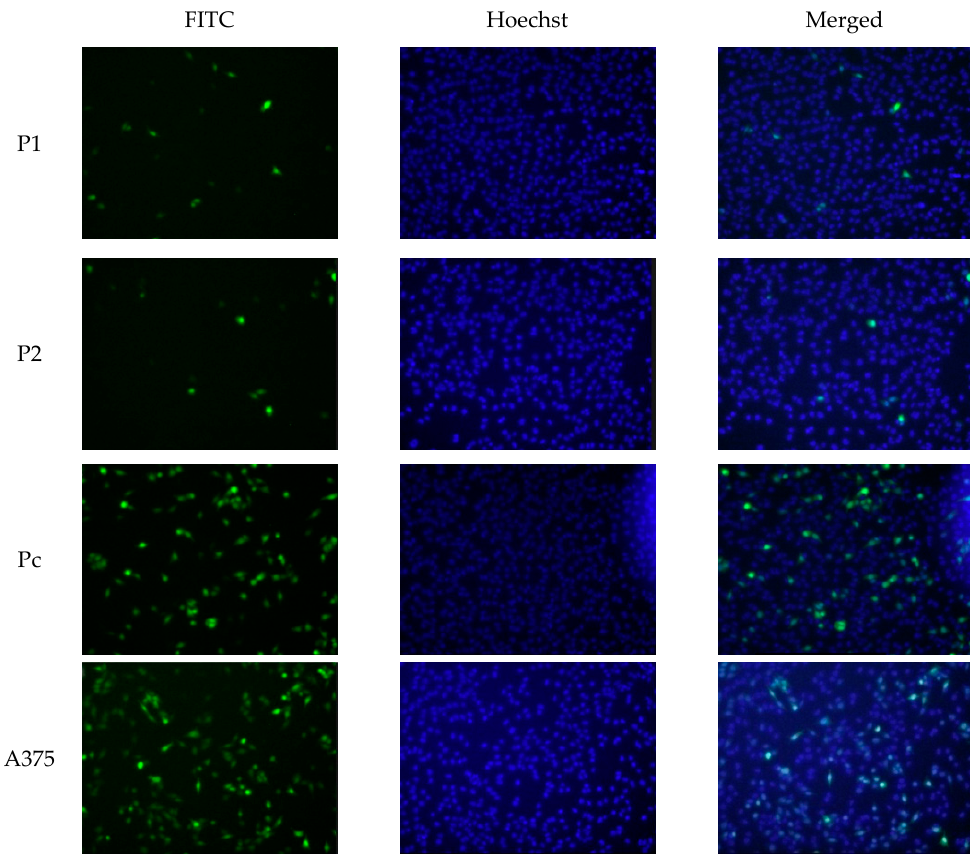
Figure 3. Immune fluorescence staining. YB-1 knockdown was validated using primary mouse anti YB-1 monoclonal antibodies and secondary goat anti-Mouse IgG antibodies tagged with green FITC fluorescent stain. The nontoxic Hoechst nuclear staining was used as well. The low expression levels of YB-1 is confirmed in P1 and P2 cell strains while higher expression levels were detected in Pc cell strain and the parent A375 cell line.